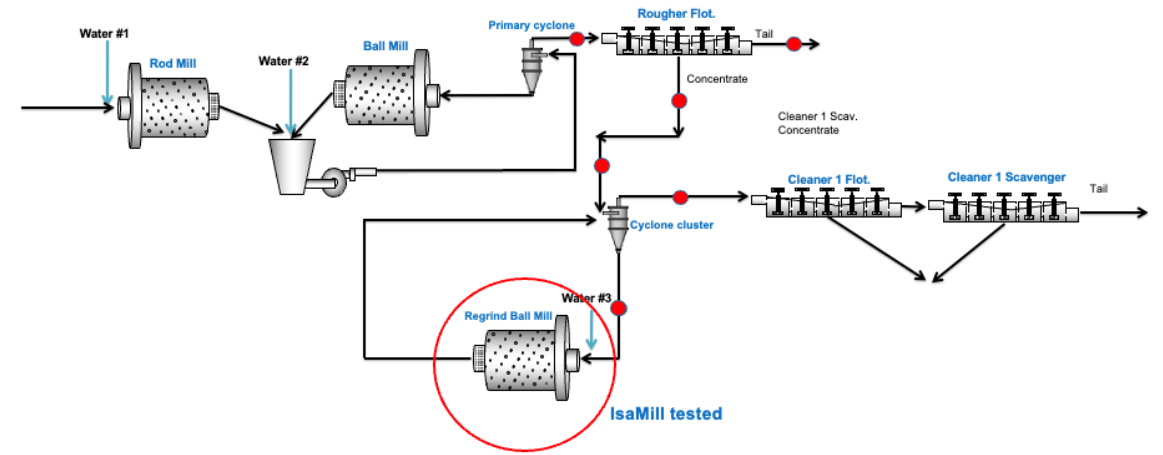
Figure 3. Flowsheet of milling and beneficiation circuit of the copper mine with IsaMill.